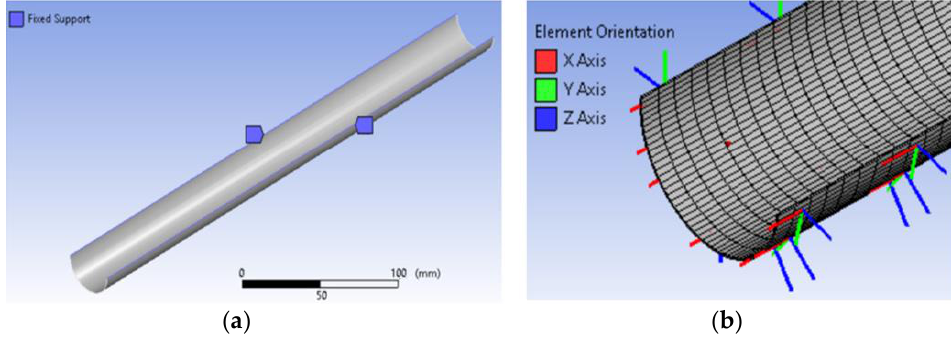
Figure 4. Experimental apparatus for the half-cane sample test detailing the method design and instrumentation.